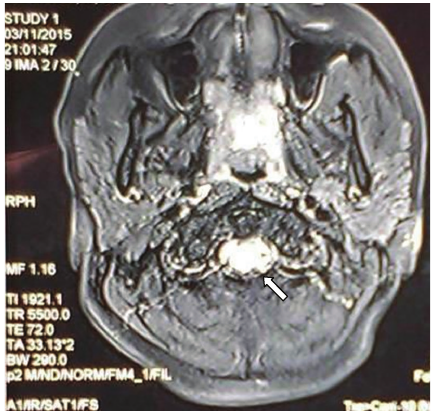
Figure 2: The same hyperintensity shown in the transverse section (white